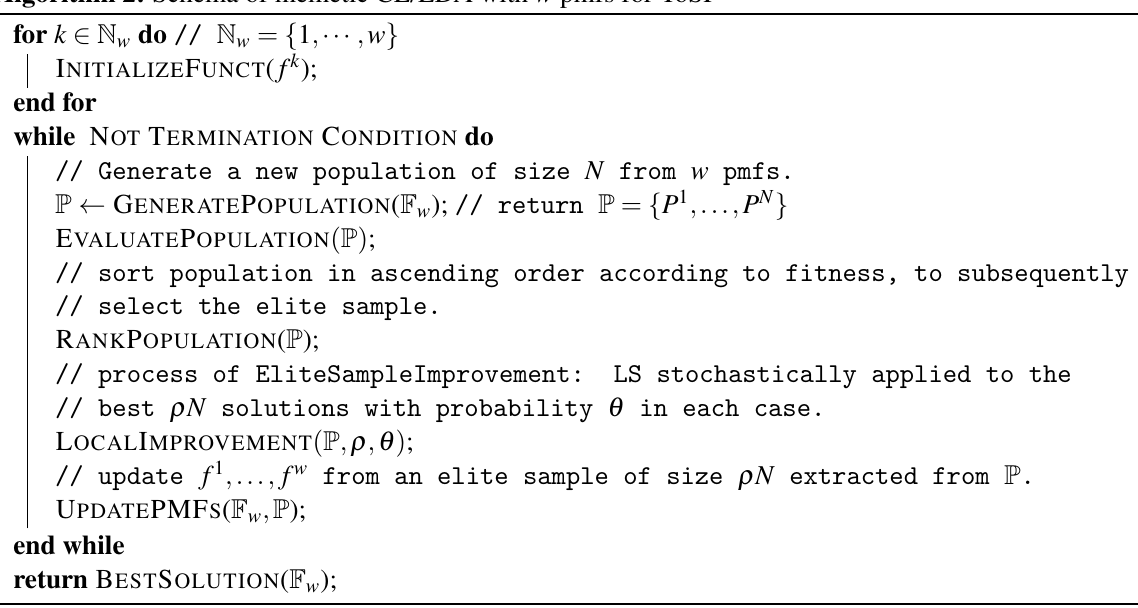
Algorithm 2: Schema of memetic CE/EDA with w pmfs for